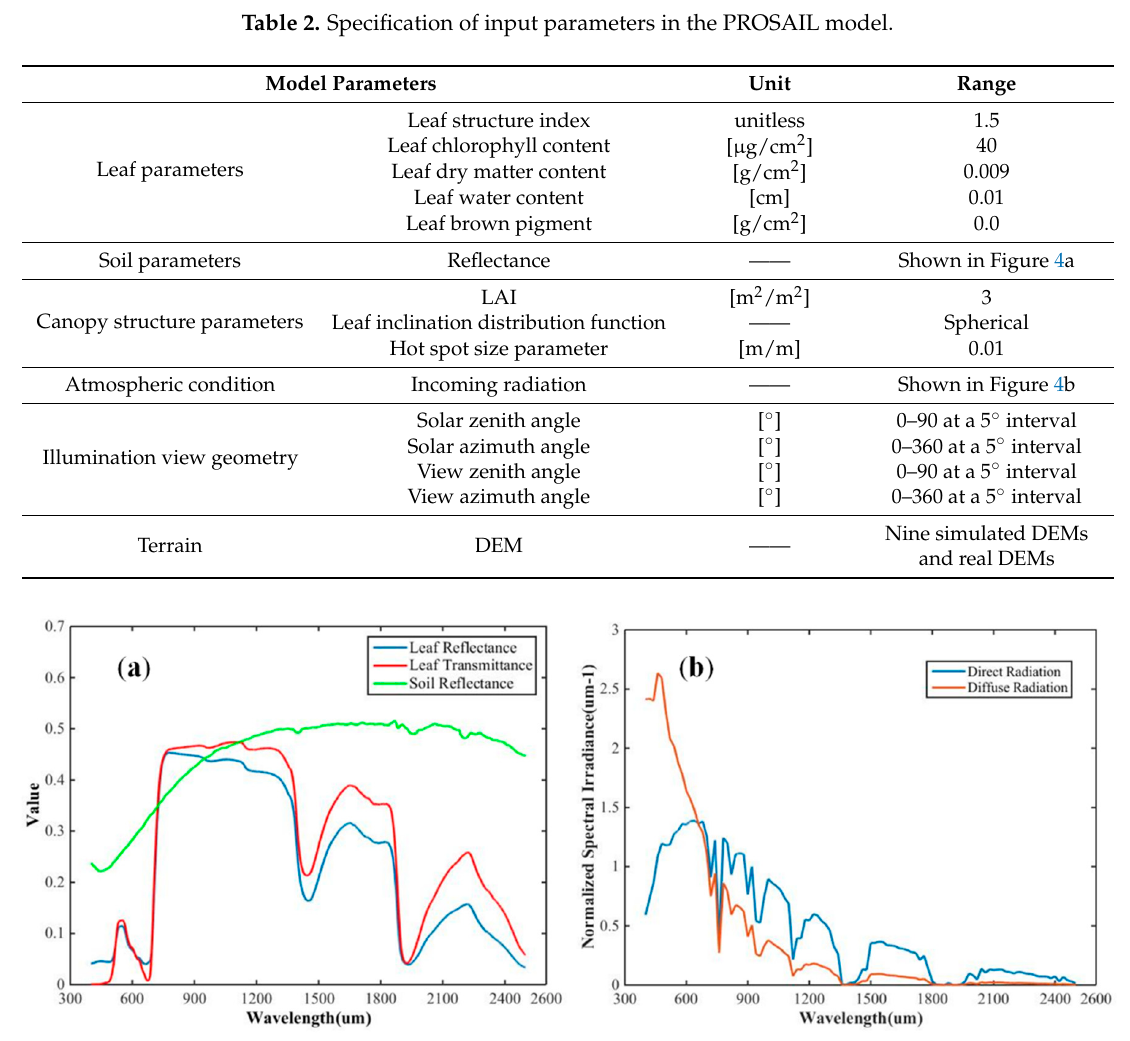
Figure 4. ( a ) Leaf reflectance, leaf transmittance and soil reflectance; ( b ) Normalized spectral irradiance curve.